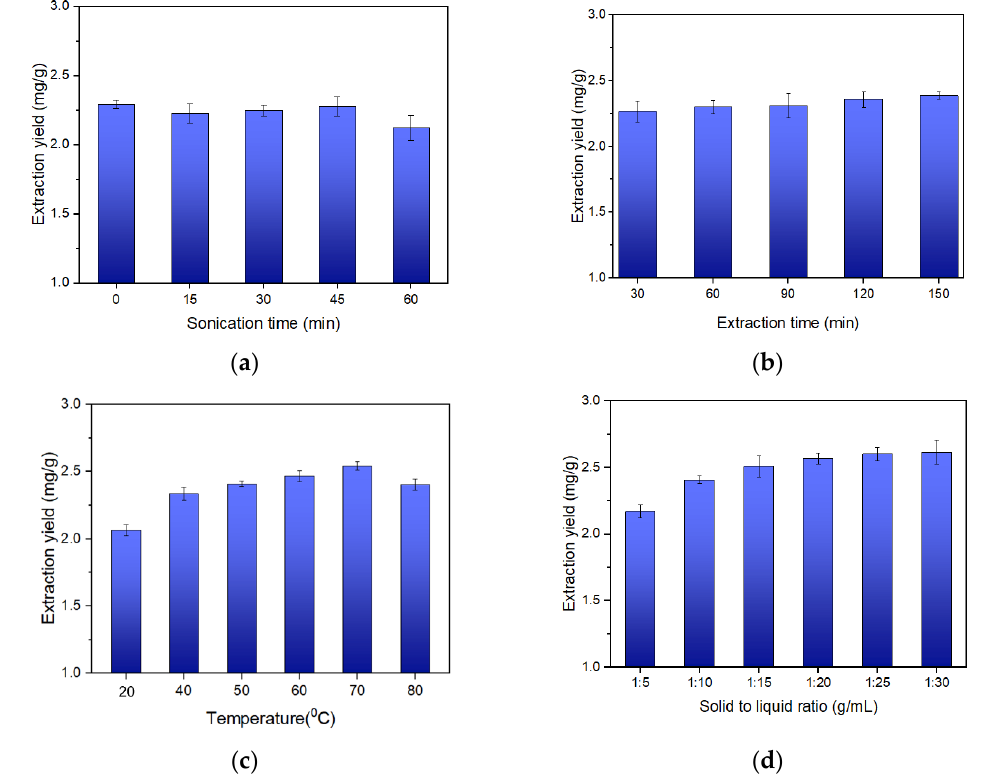
Figure 3. Effect of several variables on the extraction efficiency of isoimperatorin. ( a ) effect of sonication time, ( b ) effect of extraction time, ( c ) effect of solid to liquid ratio, ( d ) effect of solid to liquid ratio.